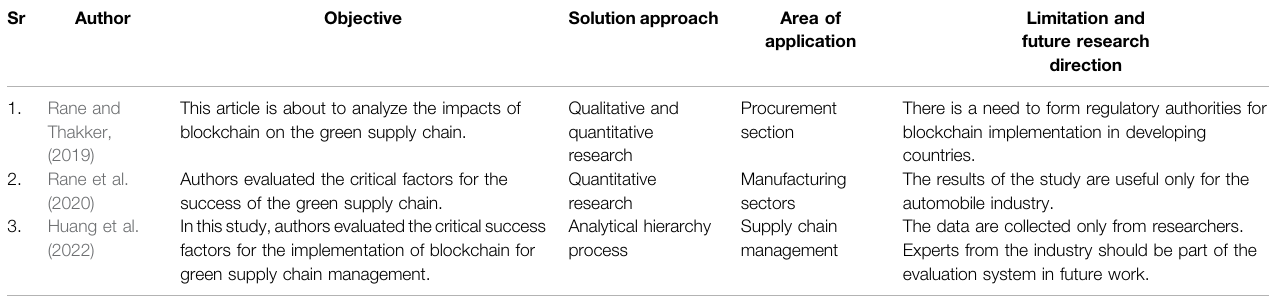
TABLE 8 | Article related to challenges and barriers in the blockchain-based green/circular supply